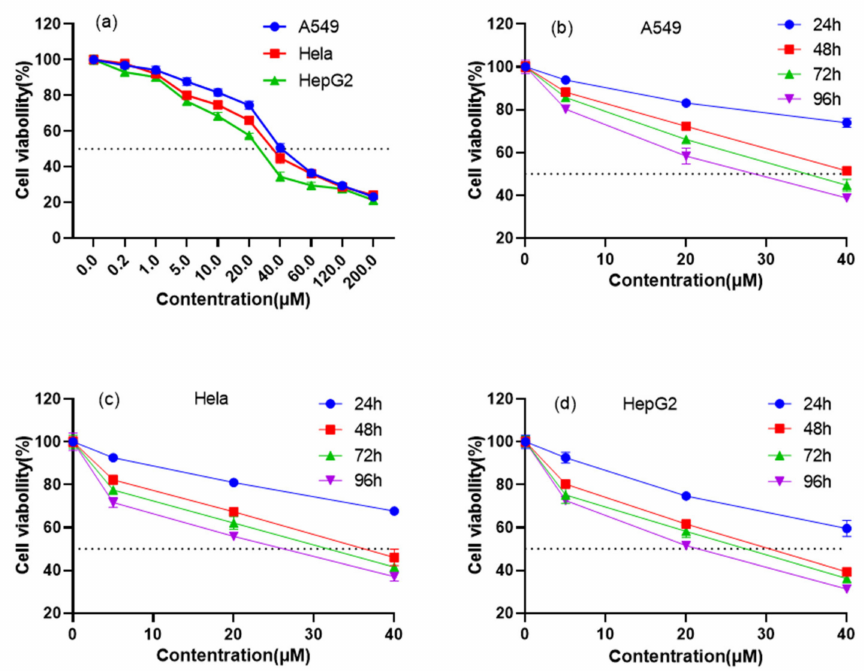
Figure 9. ( a ) Effects of complex 2 on HepG2, HeLa, and A549 cell viability and proliferation after 48 h exposure. ( b – d ) Time course of effects of complex 2 on A549, HeLa, and HepG2 cell viability and